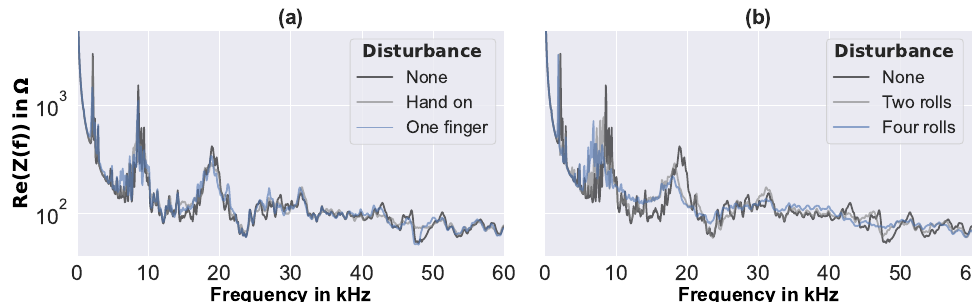
Figure 8. Examples of measured EMI spectra of the sandwich plate with perfectly circular debonding of the 29mm radius, and ( a ) hand and fingers, ( b ) compound rolls applied as artificial